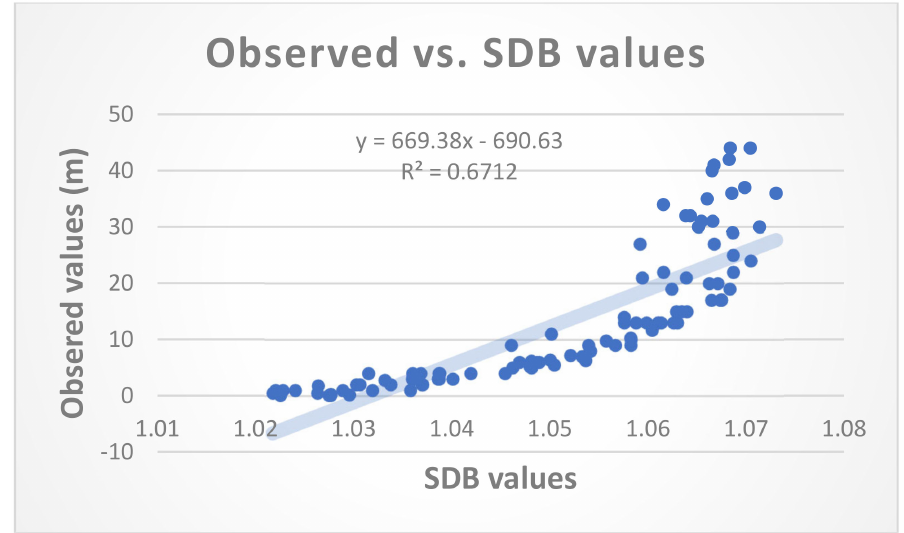
Figure 11. Determination of water depth extinction, example for in situ data and SDB from the ln(blue)/ln(green) band ratio, in Thira (top chart) and Milos (bottom chart) islands.